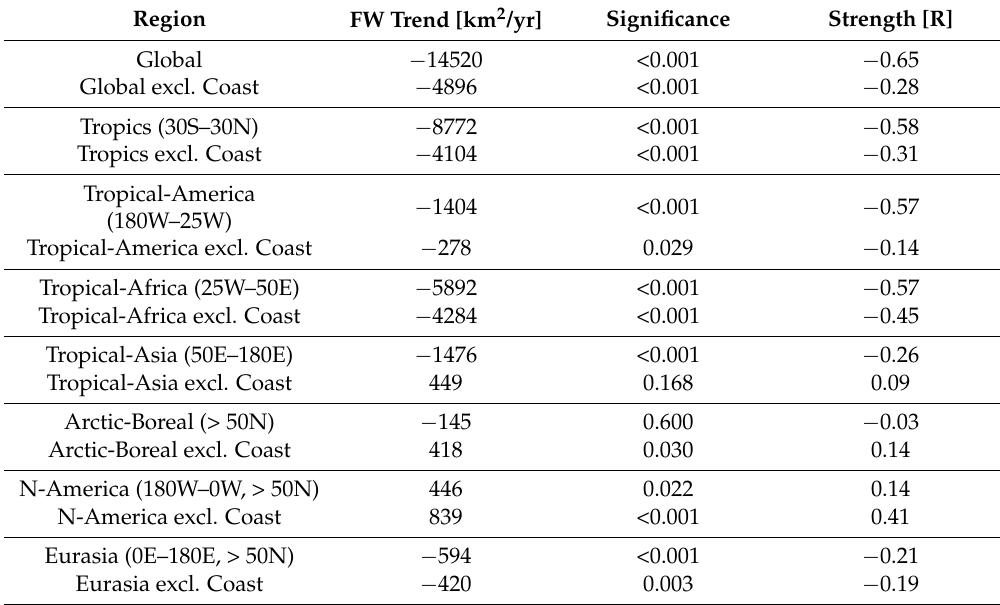
Table 9. Trend estimates (km 2 /yr), trend significance ( p ) and trend strength (R) and sign ( ˘ ) for the combined v1-ERS (1992–1999), v1-QSCAT (2000–2008) and v2-ASCAT (2009–3/2013) SWAMPS